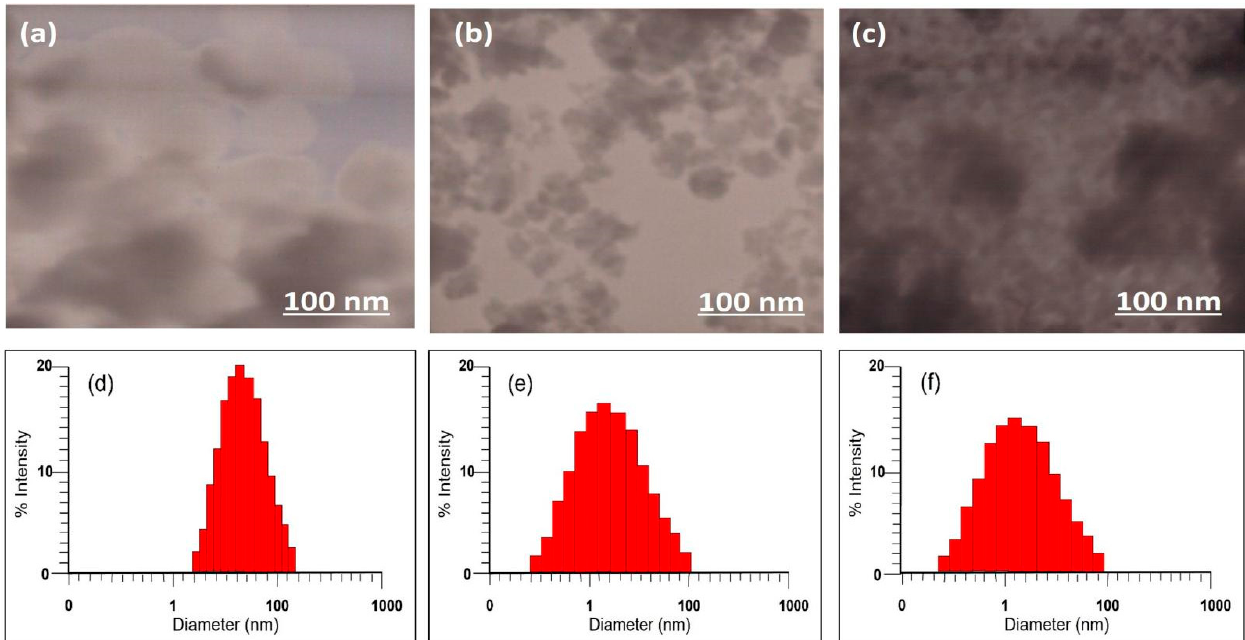
Figure 8. TEM image and histogram of titanium nanoparticles formed by: ( a , d ) Bacillus subtilis , ( b , e ) Cassia fistula and ( c , f ) hydrothermal heating showing size and shape.